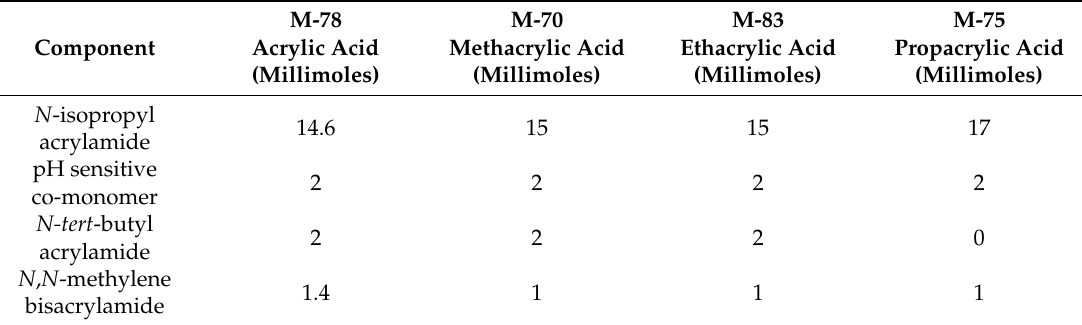
Figure 4. Ascending and descending pH profiles of polymer particles of M-75 (NIPA copolymerized with PAA) at 23 °C and 37 °C. Solid line = ascending pH profile. Dashed line = descending pH profile. Table 1. Formulation of Four Copolymers of N -isopropylacrylamide.